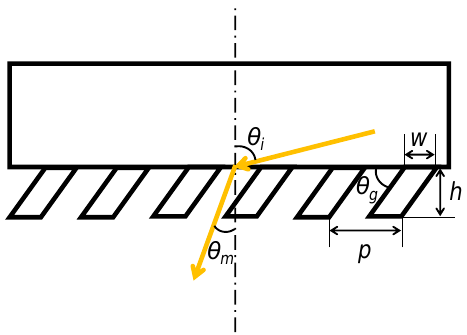
Figure 4. Cross-sectional profile of slanted grating. p is the grating period, h the grating height, w the grating width, θ g the slant angle, θ i the incident angle (relative to the grating normal), and θ m the di ff raction angle of m th